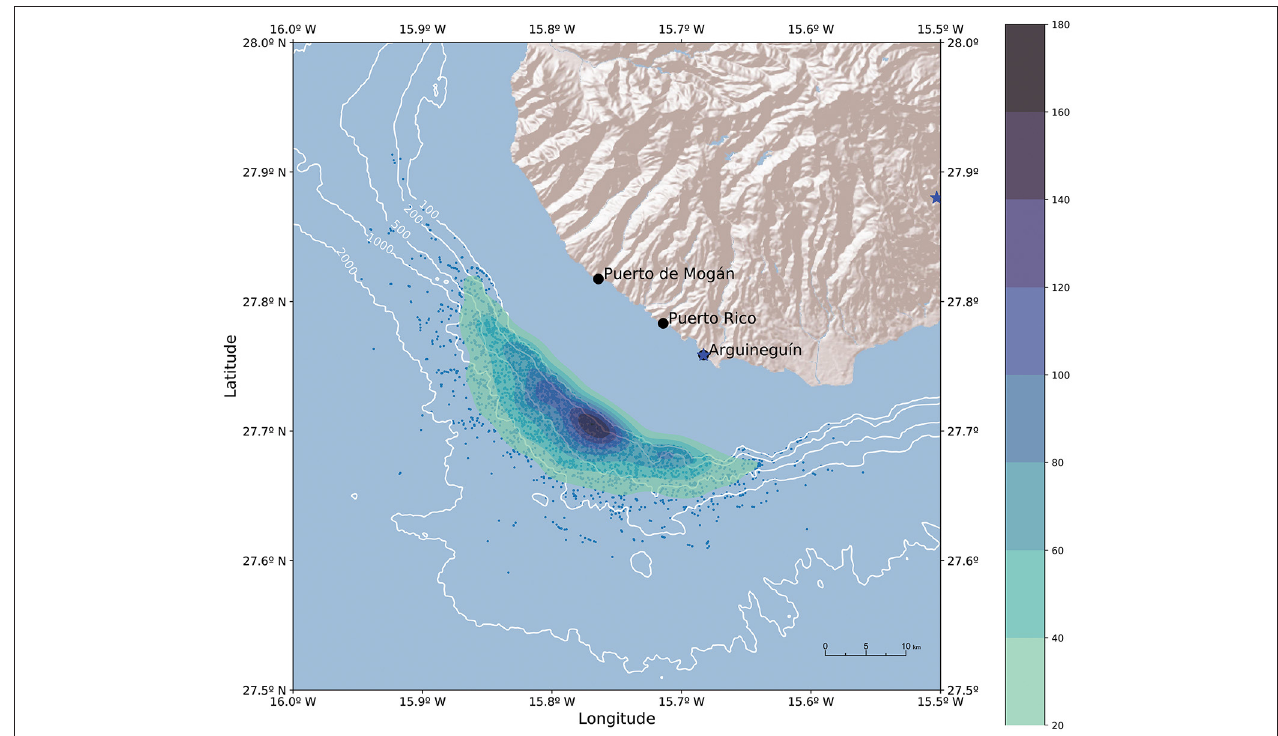
FIGURE 5 | AIS messages broadcasted from potential whale watching events (blue dots) and density map of the potential whale watching events off Gran Canaria Island. Location of the main harbors (black dots) and the AIS terrestrial stations (blue stars) in the region. White lines represent isobaths in meters.